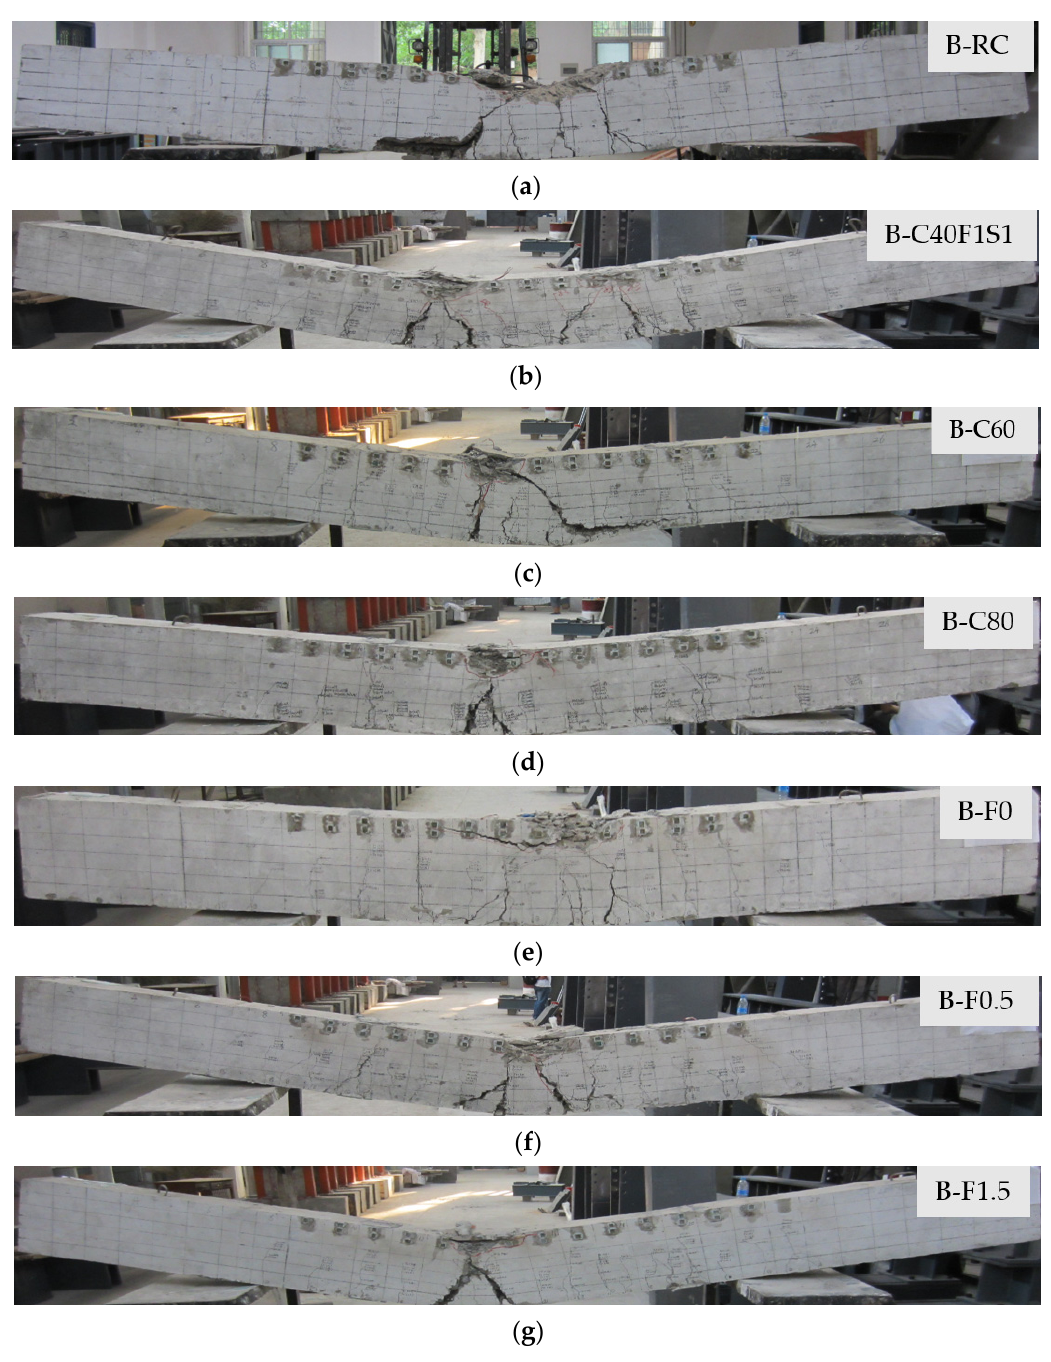
Figure 6. Bending failure process and failure modes: ( a ) B-RC; ( b ) B-C40F1S1; ( c ) B-C60; ( d ) B-C80; ( e ) B-F0; ( f ) B-F0.5; ( g ) B-F1.5